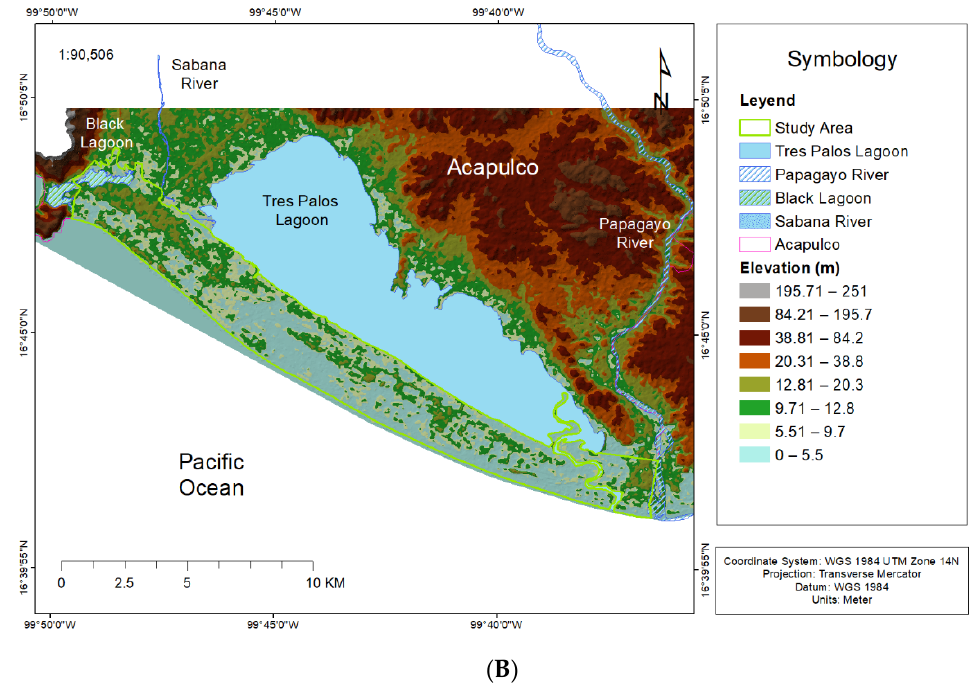
Figure 4. ( A ) Contour lines generated in the Global Mapper 20 program, with a height of 10 cm each. ( B ) Triangular irregular network (TIN) generated in ArcGIS 10.7.1 for the study area. ArcGIS 10.7.1 used contour lines to build a triangulated irregular network (TIN). The